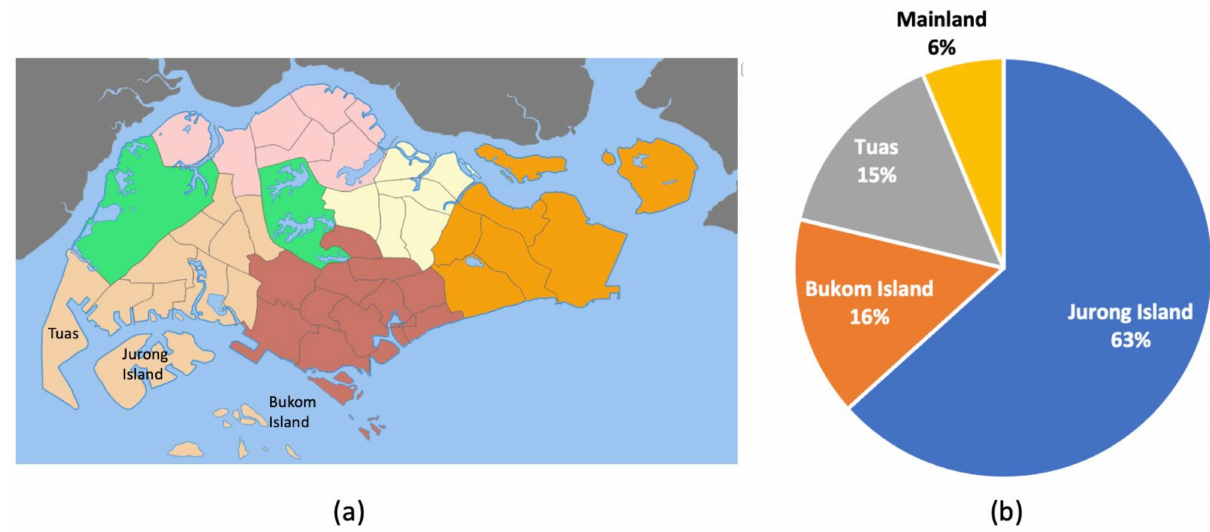
Figure 3. ( a ) Map of Singapore, ( b ) CO 2 emissions from industry and power by location. Singapore’s Emission